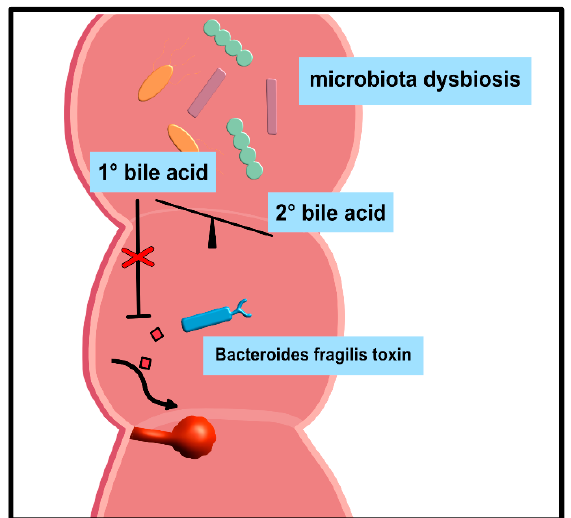
Figure 3. Influence of bile acid (BA) composition on colonic cell responses to the toxin of Bacteroides fragilis . The disruption of intestinal microbiota reduces the accumulation of primary BAs in the gut. Subsequently, the protective effect of primary BAs on colonic cell responses is lost and renders these cells susceptible to damage upon exposure to the toxin of Bacteroides fragilis .